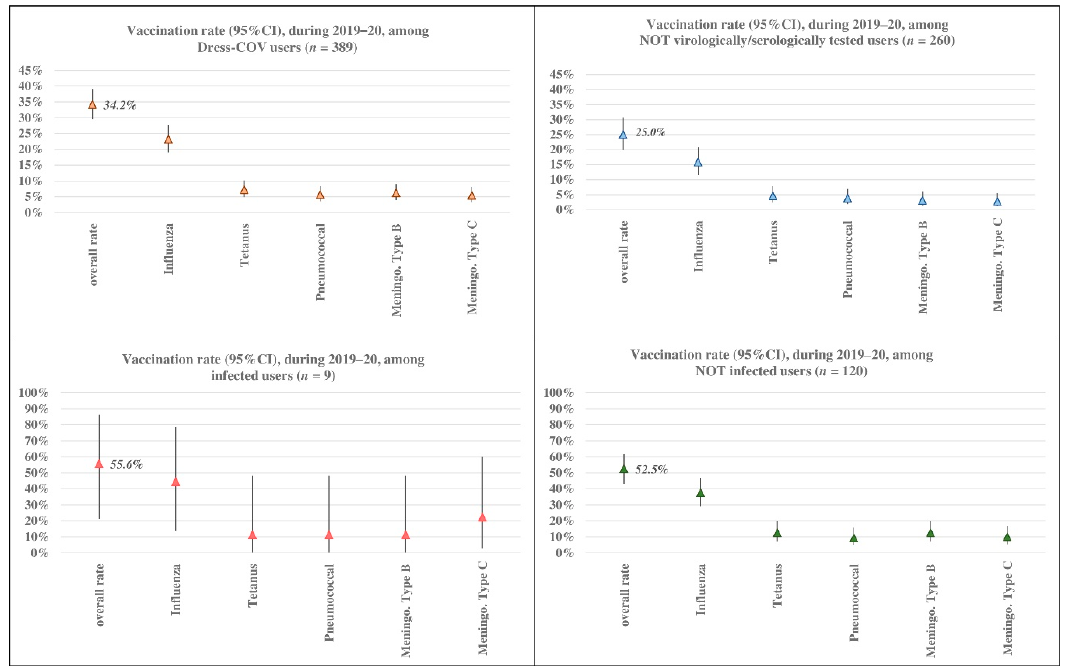
Figure 10. Dress-COV: vaccination rate (2019–2020) by propensity to tests and their results.